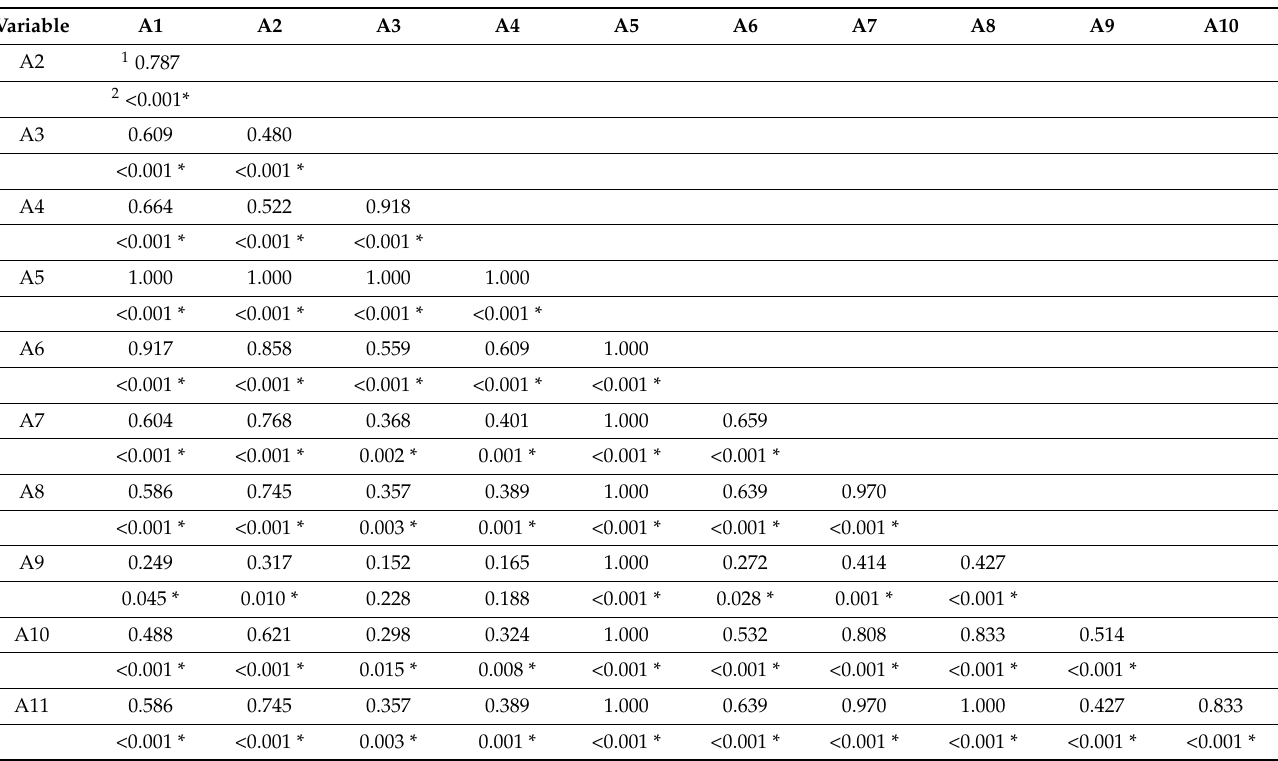
Table 3. Correlation outcomes between ‘yes’ responses to questions from managers/supervisors regards how their good practices would contribute to cleaner food